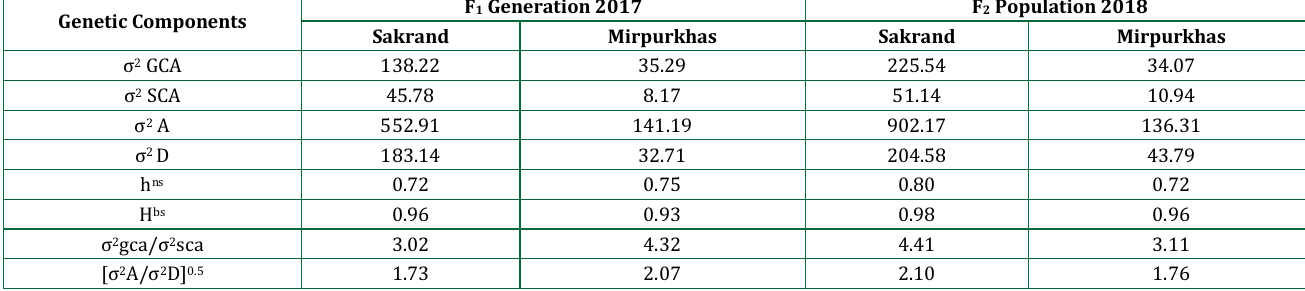
Table 2: Genetic Components of Variance For Cotton Leaf Curl Virus Disease Incidence